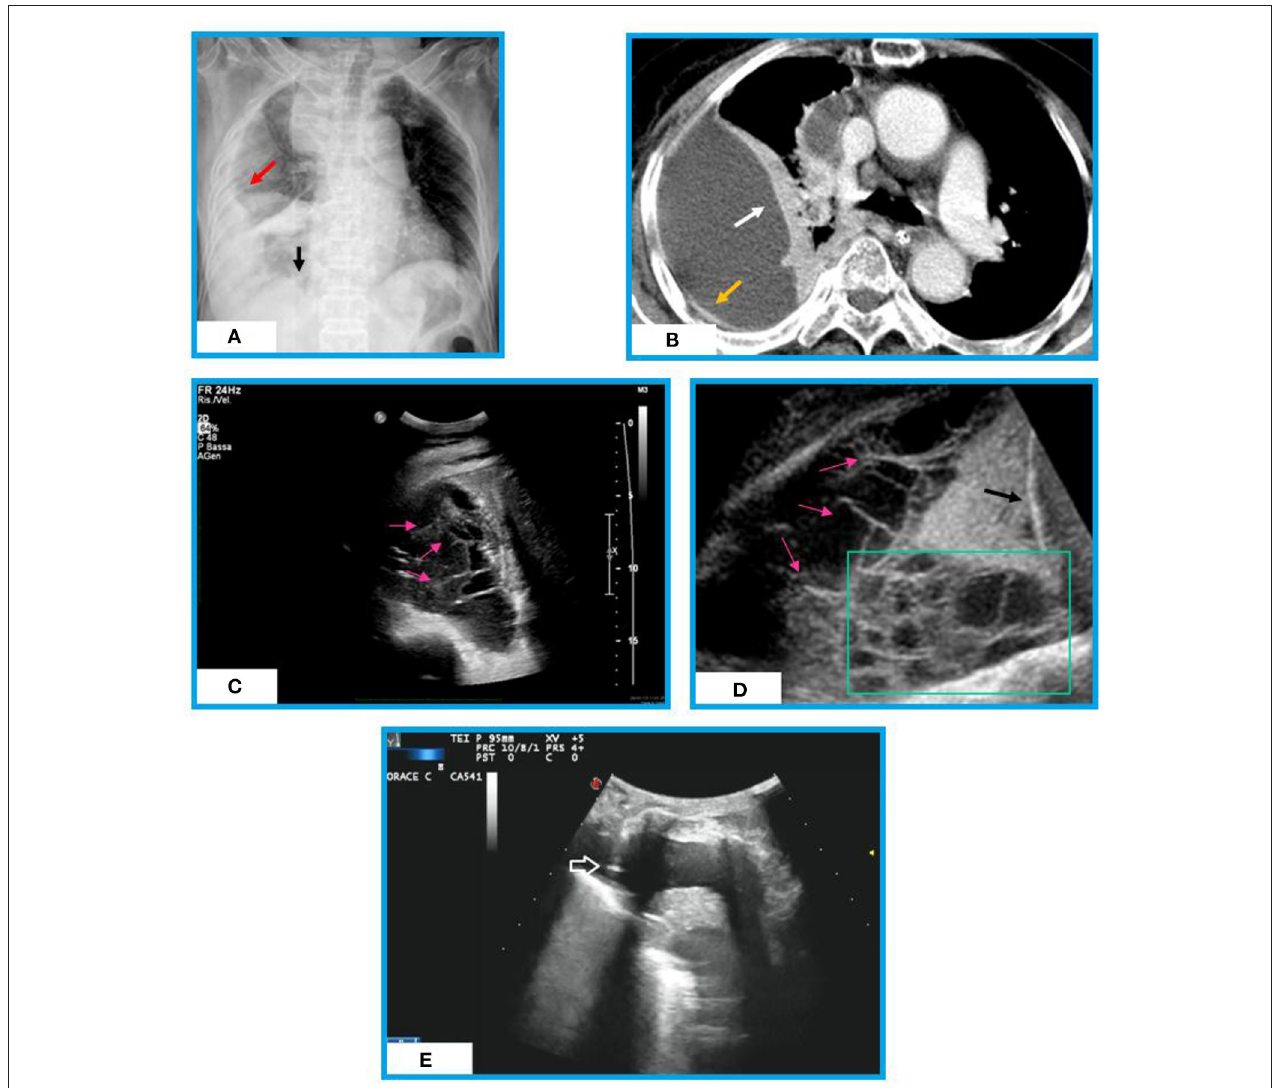
FIGURE 1 | Chest X-ray, chest CT and Ultrasound appearances of an organized effusion in a patient with post-primary TB. (A) Chest X-ray shows a right pulmonary opacity that is not in the gravity dependent location (red arrow). We are able to see the diaphragm medially (black arrow). No septation is seen. (B) Chest CT shows a large loculated right pleural effusion surrounded by a thickened pleural wall (yellow arrow) and lung atelectasis (white arrow). No septation is assessed inside. (C) Thoracic ultrasound (TUS) scan reveals presence of multiple fibrin strands (i.e., thin, mobile, linear hyperechoic structures, pink arrows) forming a septated pleural effusion (complex US aspect). (D) TUS lower thoracic view (diaphragm, black arrow) of the pleural effusion showing multiple septations (pink arrows) and loculations (green box). (E) TUS scan during ultrasound-guided thoracentesis allowing real-time visualization of the needle (white arrow) in an anechoic pleural